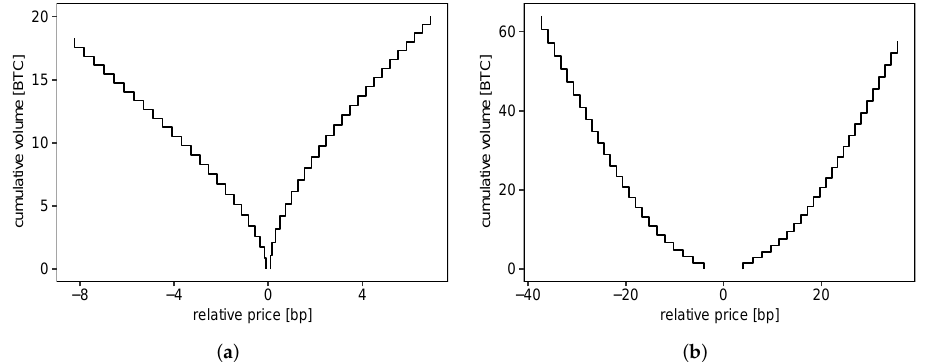
Figure A1. Time–averaged limit order book. We plot the time-averaged spread (relative to the respective mid price) and time-averaged volume for each level of the order book. ( a ) Coinbase BTC/USD market; ( b ) Bitstamp BTC/USD